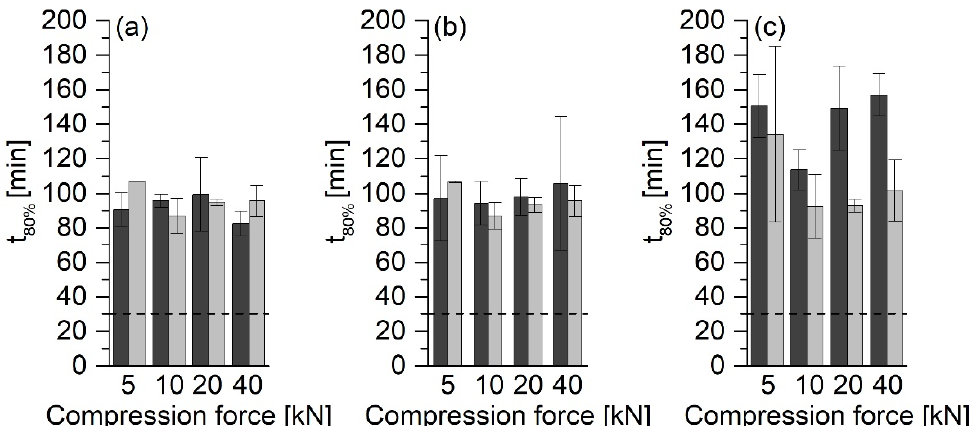
Figure 8. T 80% values of tablets without MCC 200. Dark gray bars: ASD directly after preparation; light gray bars: PM directly after preparation. ( a ) ASD/PM VA30 tablets, ( b ) ASD/PM VA40 tablets, ( c ) ASD/PM VA50 tablets, average ± SD, n = 2.